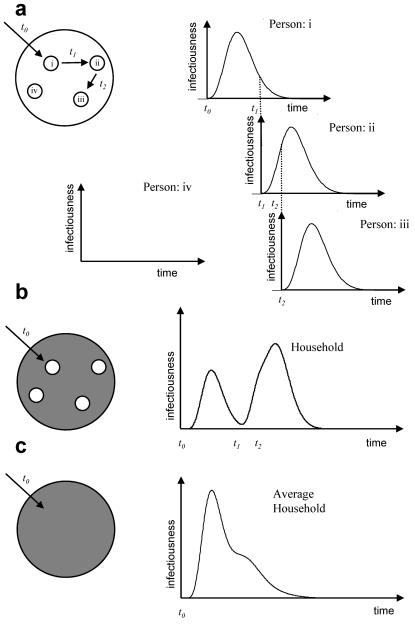
Concept of approach.As a starting point, consider a household of size 4. A, illustrates an infection being transmitted in this household, with the index case (i) being infected outside the house at time t0. They then infect exactly one person (ii) at time t1, and (ii) in turn infects person (iii) at time t2. Person (iv) escapes infection altogether. The infectiousness of each individual over time is also shown, with infection events highlighted. B, illustrates how these events can be reinterpreted by taking the unit of infection as the household, infected at time t0 and with total infectiousness of the household defined as the sum of the four individual curves shown in A. The aim of the method is then to average this process over all possible chains of infection in the household, and all household sizes, to obtain the characteristic infectiousness profile of a household, as shown in C, where the household is no longer decomposed into its constituent units at all.